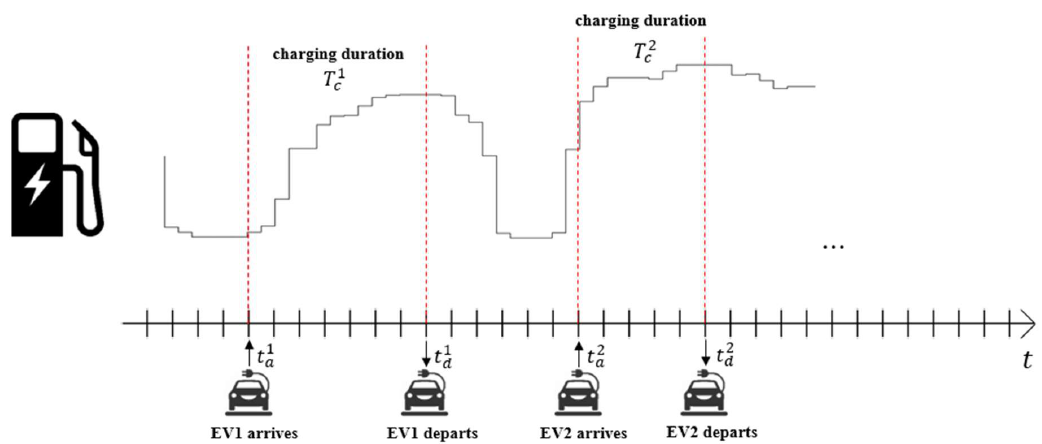
Figure 1. A situation where multiple electric vehicles (EVs) arrive at a single charger in a specific location and charge during the charging period under hourly pricing scheme . 149